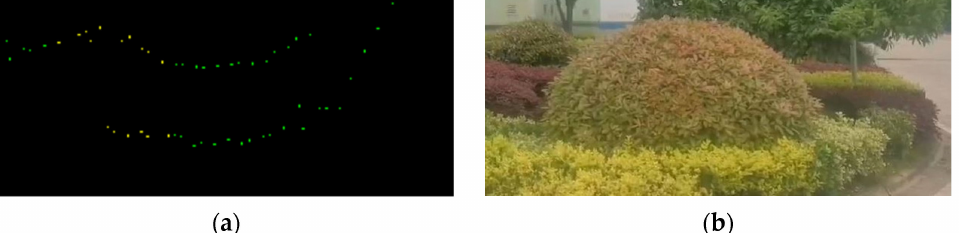
Figure 8. Repaired point cloud. ( a ) Point cloud. ( b ) Actual object. The yellow dots in ( a ) represent the repaired background point cloud after removal of dynamic objects. ( b ) represents the actual background of the frame data. The yellow point restores the spherical flowerbed in the green belt, and the geometric error, calculated through comparison of the circle equation of the real object and the point cloud, is about 4.3%. Taking into account the selection of the plane where the circle is located, the accuracy of the measuring tool and other factors, it was considered that the repair algorithm could restore the object